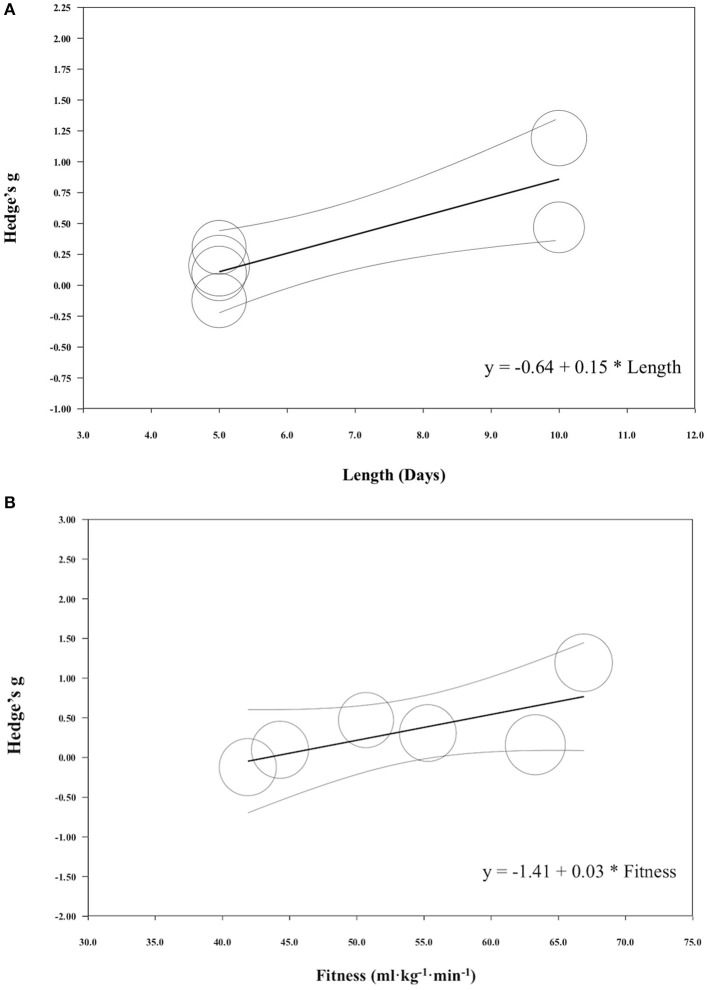
(A) Regression of Hedge's g on induction length for mean power exercise performance following heat acclimation. Solid black bars represent the mean Hedge's g. Each circle represents individual studies. The size of the circle represents the weight of that study that was applied in the analysis. Smaller circles indicate lower weight and larger circles indicate higher weight. (B) Regression of Hedge's g on fitness level for mean power exercise performance following heat acclimation. Solid black bars represent the mean Hedge's g. Each circle represents individual studies. The size of the circle represents the weight of that study that was applied in the analysis. Smaller circles indicate lower weight and larger circles indicate higher weight.